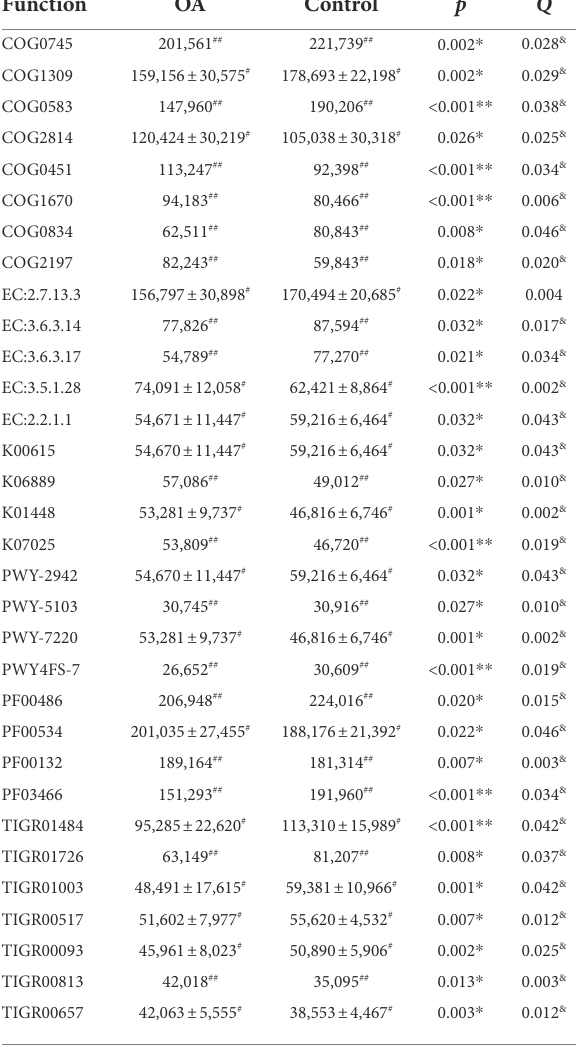
TABLE 5 The absolute abundance of functions with statistical difference between groups.